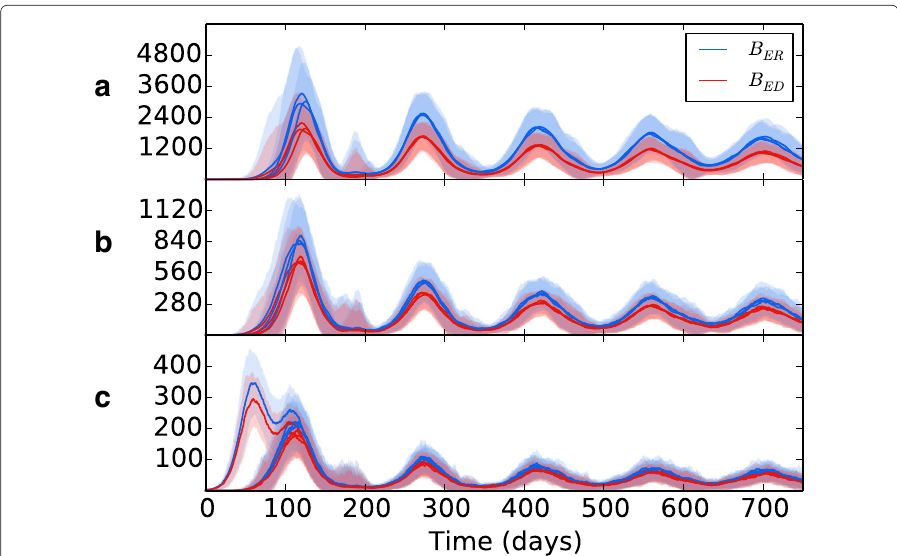
Fig. 8 The bacterial levels of B ER and B ED in a apical patches, b middle patches and c basal patches. Line is mean, shading is standard deviation. All three regions show similar levels between replicating (blue) and dormant (red) bacteria, with a slight majority to replicating bacteria in